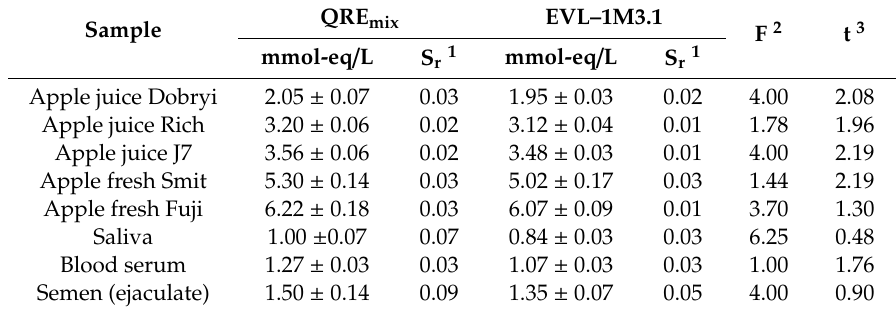
Table 5. AOA determination results of solutions (fruit juices and biofluids) obtained using the